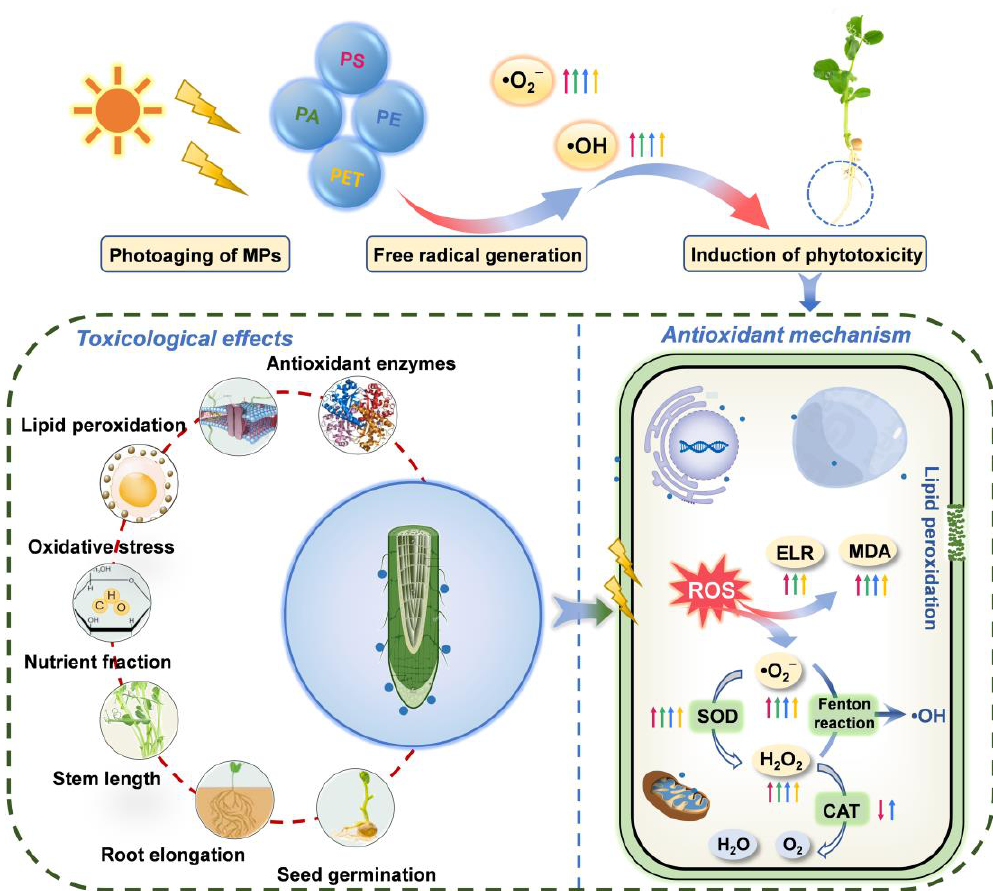
Figure 6. Schematic diagram of the mechanisms of physiological toxicity and antioxidant regulation induced by photoaging of MPs, including seed germination, root elongation, stem length, nutrient fraction, oxidative stress, lipid peroxidation, and antioxidant enzymes, as well as the scavenging mechanisms of the reactive oxygen species (ROS) via the antioxidant system. Straight arrows represent photoaged MPs; red arrows represent PS, green arrows represent PA, blue arrows represent PE, and orange arrows represent PET; arrows pointing up represent an increase, and arrows pointing down represent a decrease.